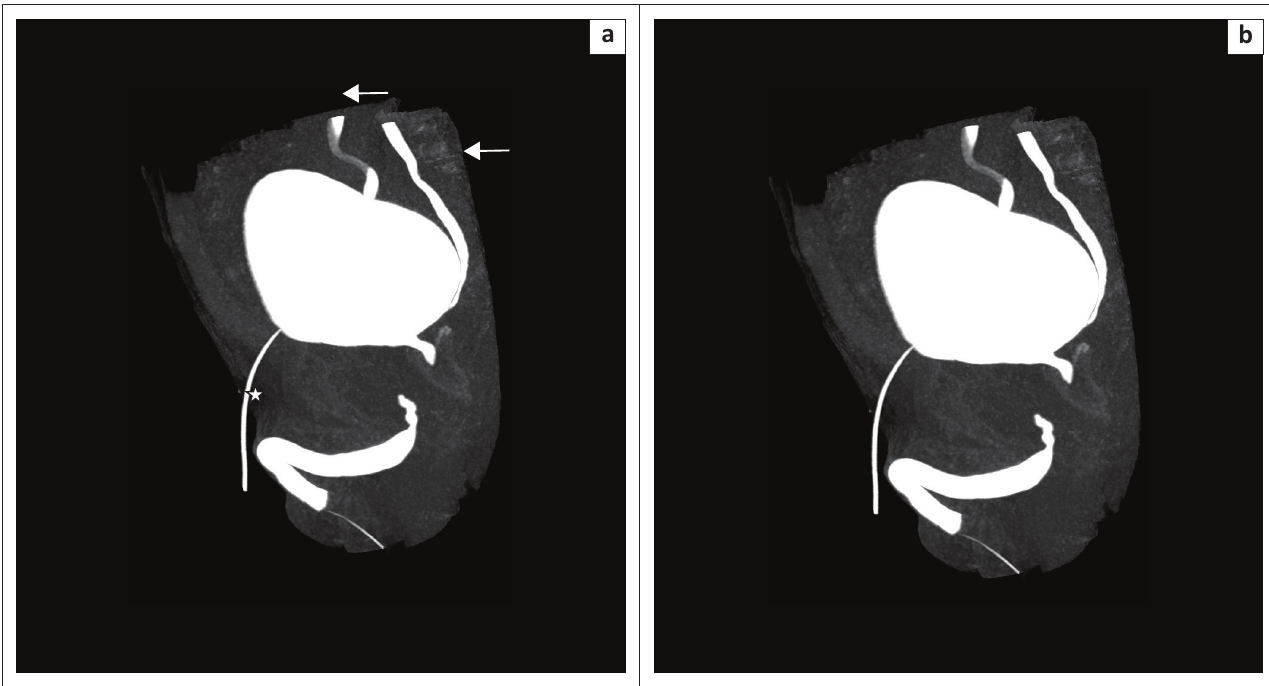
FIG URE 15: Vesico-ureteric reflux can be seen on both sides (arrows) in a patient with a posterior urethral distraction defect. Contrast in the bladder was filled through the supra-pubic catheter seen in situ (star). Retrograde filling revealed a normal anterior